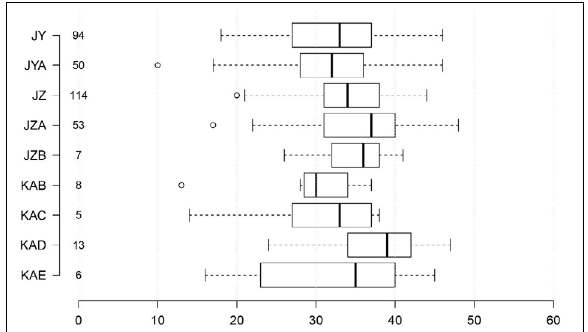
Box plots summarising the lengths of opercula of Turbo sarmaticus from Klipdrift Cave through time. Centre lines show the medians; box limits indicate the 25th and 75th percentiles as determined by R software; whiskers extend 1.5 times the interquartile range from the 25th and 75th percentiles; outliers are represented by dots. Number of sample points per layer is given on the left. (Constructed using BoxPlotR at http://shiny.